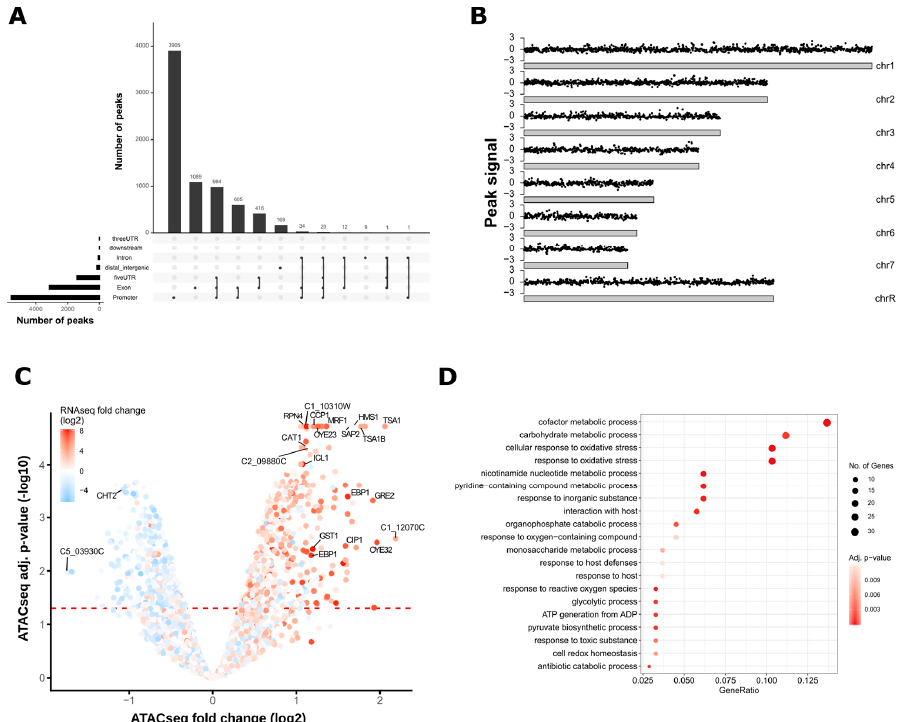
Figure 3. ATAC-seq nucleosome-free peak annotation and differential ATAC-seq peak analysis. ( A ) The majority of called ATAC-seq nucleosome-free peaks are within gene promoters. The vertical bars of the UpSet plot represent the number of peaks spanning one or more specific genomic regions (overlaps of genomic regions are indicated by connection lines between the black dots). For instance, the first bar indicates the number of peaks occurring exclusively in promoters, while the third bar represents peaks spanning promoter, 5 ′ UTR (untranslated regions) and exonic regions. The horizontal bars show the total number of peaks for each genomic annotation, independent of overlaps. ( B ) Karyoplots showing the genomic peak location on each chromosome of differential ATAC-seq nucleosome-free read signals (log2-fold change) of H 2 O 2 -treated vs. non-treated cells. The log2-fold change is depicted on the y-axis and the x-axis represents each chromosome of the C. albicans genome. ( C ) Increased ATAC-seq nucleosome-free peak signals correlate with increased transcript levels. Volcano plot depicting the differential peak signal analysis of nucleosome-free ATAC-seq peak signals between H 2 O 2 -treated and non-treated cells. The y-axis represents the negative log10 adjusted p -value (false discovery rate, FDR) and the x-axis depicts the log2 fold change between H 2 O 2 treatment vs. no treatment. The horizontal dashed red line indicates an FDR of 0.05. Each dot represents one peak annotated to the next downstream gene, which is overlaid with a color gradient indicating the log2-fold change (H 2 O 2 treatment vs. no treatment) from RNA-seq data. ( D ) Peaks with increased ATAC-seq nucleosome-free signals in H 2 O 2 -treated cells are upstream of genes related to the oxidative stress response. The gene ratio indicates the proportion of genes enriched in the indicated GO term relative to input genes with increased chromatin accessibility after H 2 O 2 stress. The color scale represents the adjusted p -values of the GO enrichment